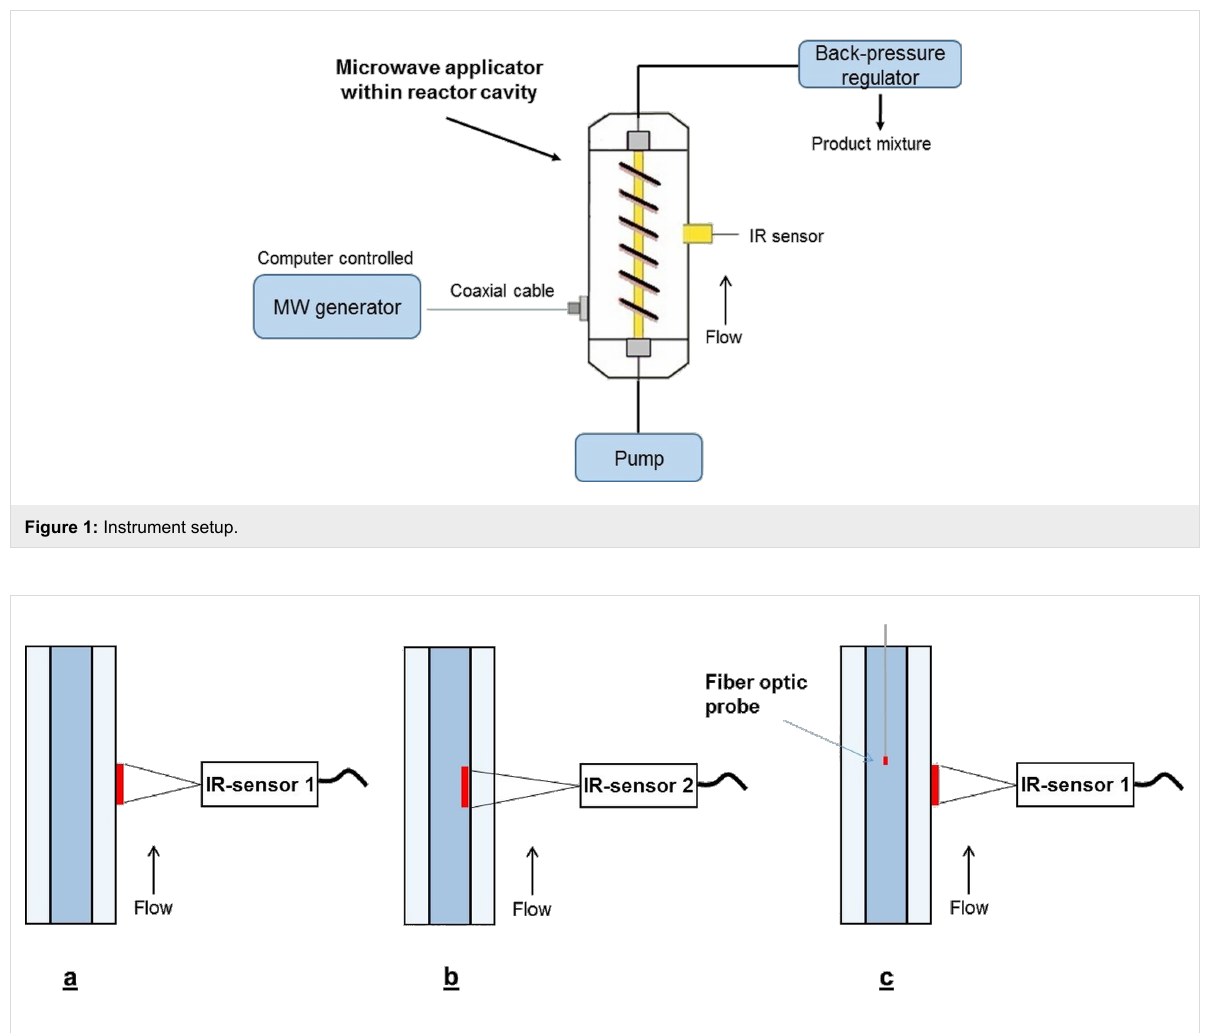
Figure 2: (a) Setup of system with temperature measurement by IR sensor 1. (b) Illustration of temperature measurement with IR sensor 2. (c) Simul- taneous measurement of temperature by IR sensor 1 and an internal fiber optic